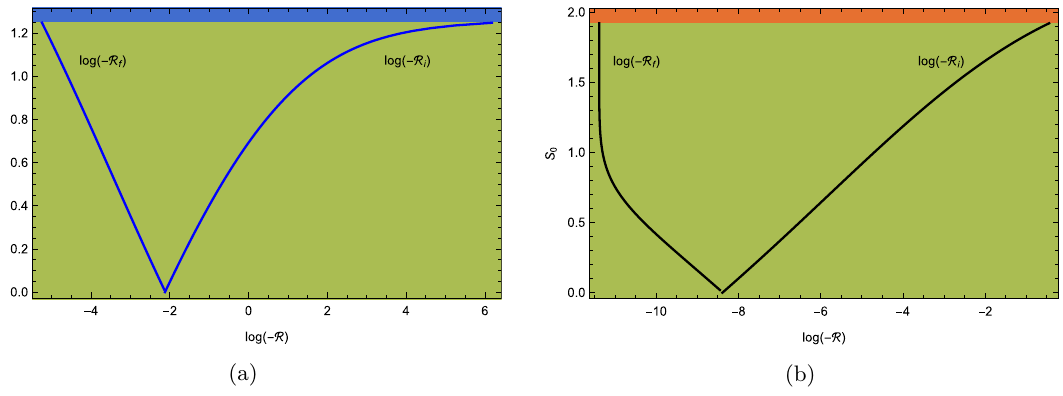
, and black curve 20